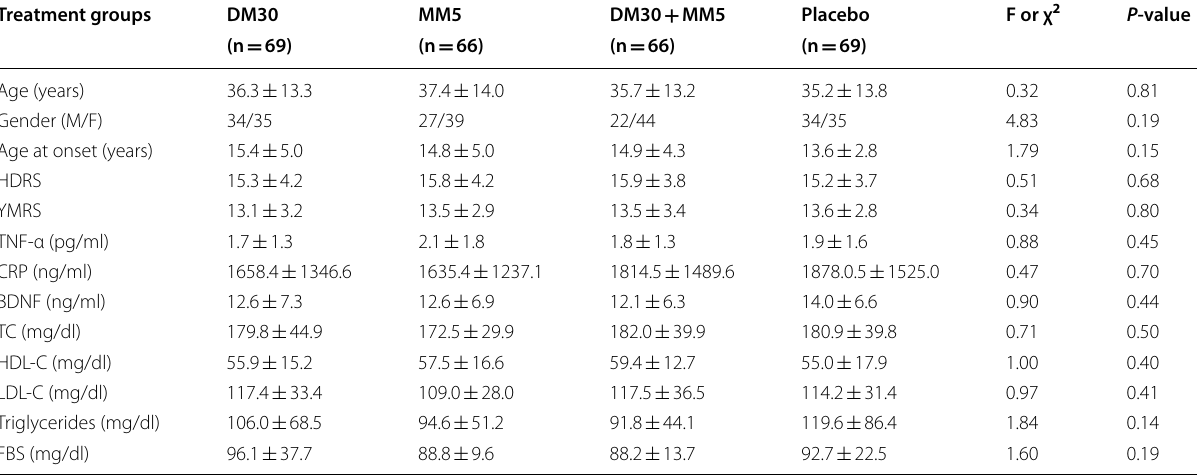
All data are mean